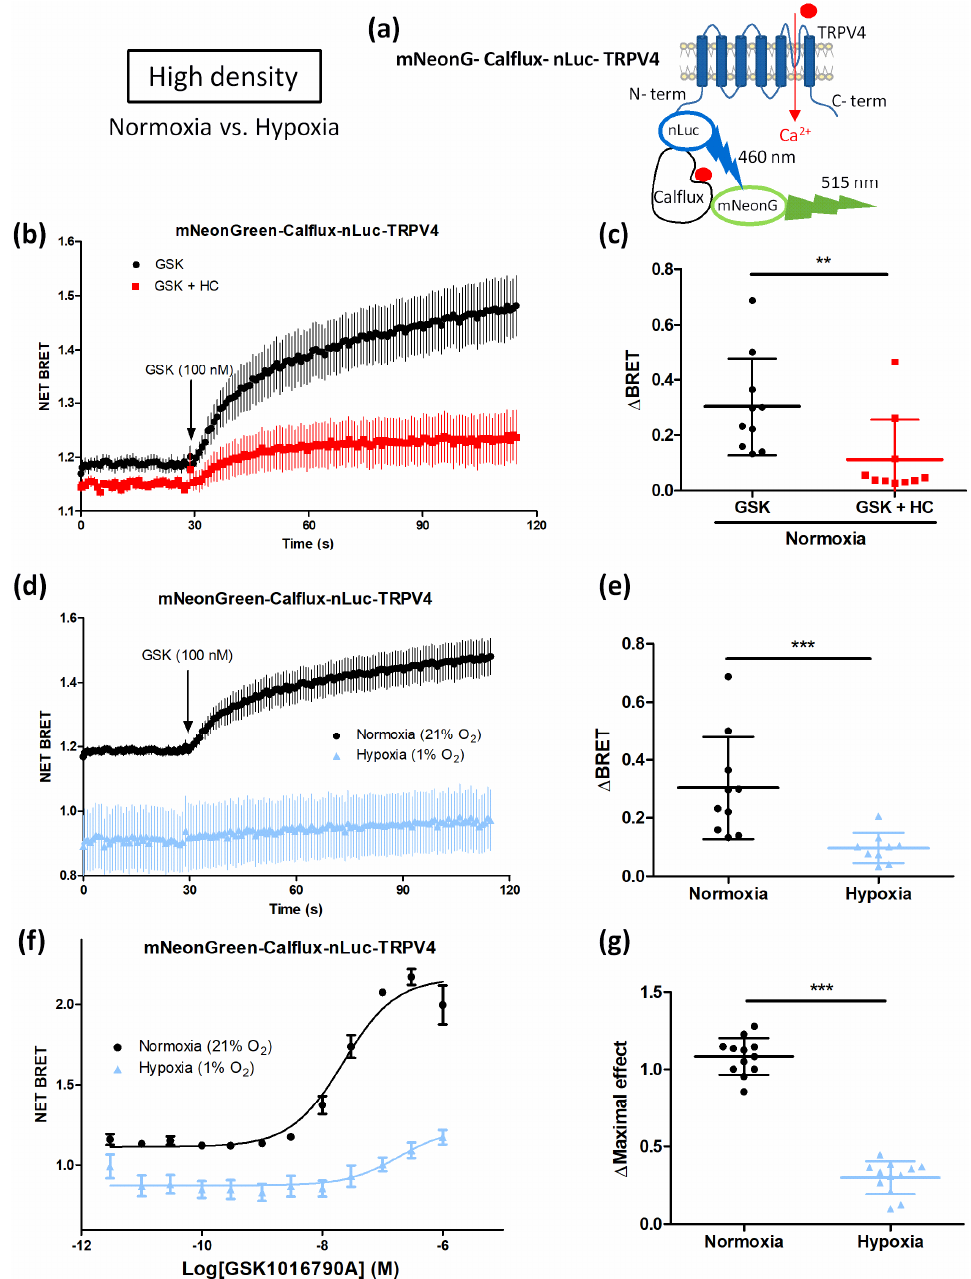
Figure 9. Cell confluence alters Ca 2+ influx through TRPV4 in transiently mNeonG-Calflux-nLuc- TRPV4-transfected HEK293T cells cultured under hypoxia (1% O 2 ) for 48 h at high cell confluence (3 × 10 5 cells/cm 2 ). ( a ) Schematic representation of mNeonG-Calflux-nLuc-TRPV4. ( b ) Kinetic BRET measurement of the effect of GSK1016790A (100 nM, applied as indicated by the arrow) on cells transfected with mNeonG-Calflux-nLuc-TRPV4 in presence or absence of HC067047 (1 µ M) and cultured at high cell confluence (3 × 10 5 cells/cm 2 ) under normoxia (21% O 2 ), and ( c ) maximal amplitude ( ∆ BRET). ( d ) Kinetic BRET measurement of the effect of GSK1016790A (100 nM) on cells transfected with mNeonG-Calflux-nLuc-TRPV4 cultured at high cell confluence under normoxia or hypoxia (1% O 2 ) for 48 h, and ( e ) maximal amplitude ( ∆ BRET). ( f ) Concentration–response curves of the effect of GSK1016790A on HEK293T cells transfected with mNeonG-Calflux-nLuc-TRPV4 BRET probe and cultured under normoxia or hypoxia at HD, and ( g ) maximal concentration–response curve amplitude ( ∆ Maximal effect). Data are expressed as mean value ± SD. The number of independent experiments is indicated in brackets. Significant difference is indicated by two asterisks when p < 0.01 and three asterisks when p < 0.001, Mann–Whitney